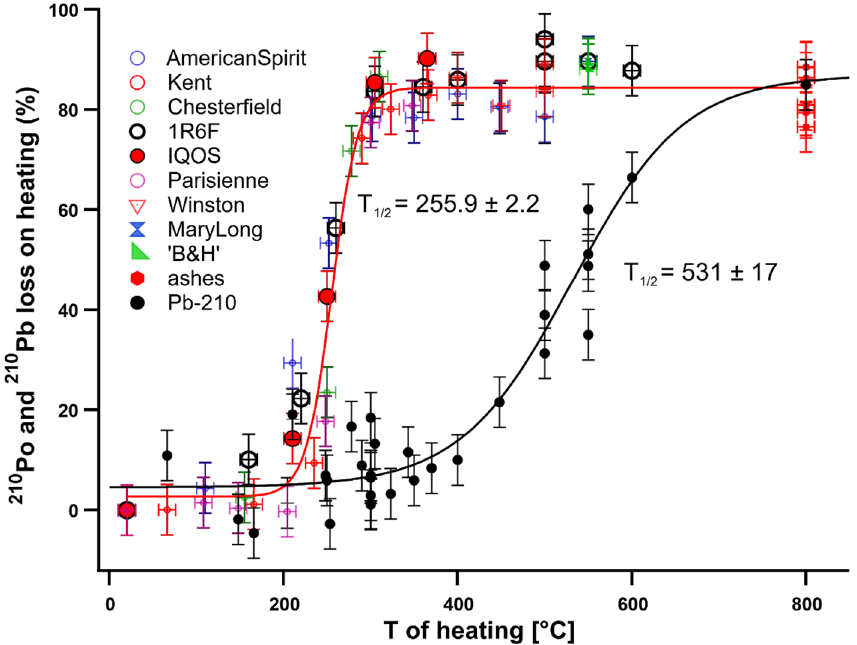
Figure 2. Percentage (%) of 210 Po and 210 Pb loss on heating for cigarette heated homogeneously in a copper cylinder. T 1/2 represents the temperature at which half of the 210 Po or 210 Pb activity is lost from the tobacco cigarette filler. 1R6F: large black open circle; Heets: large red closed circle. 800 °C has been fixed as the maximum temperature reached during conventional smoking (ashes retrieved from a conventional